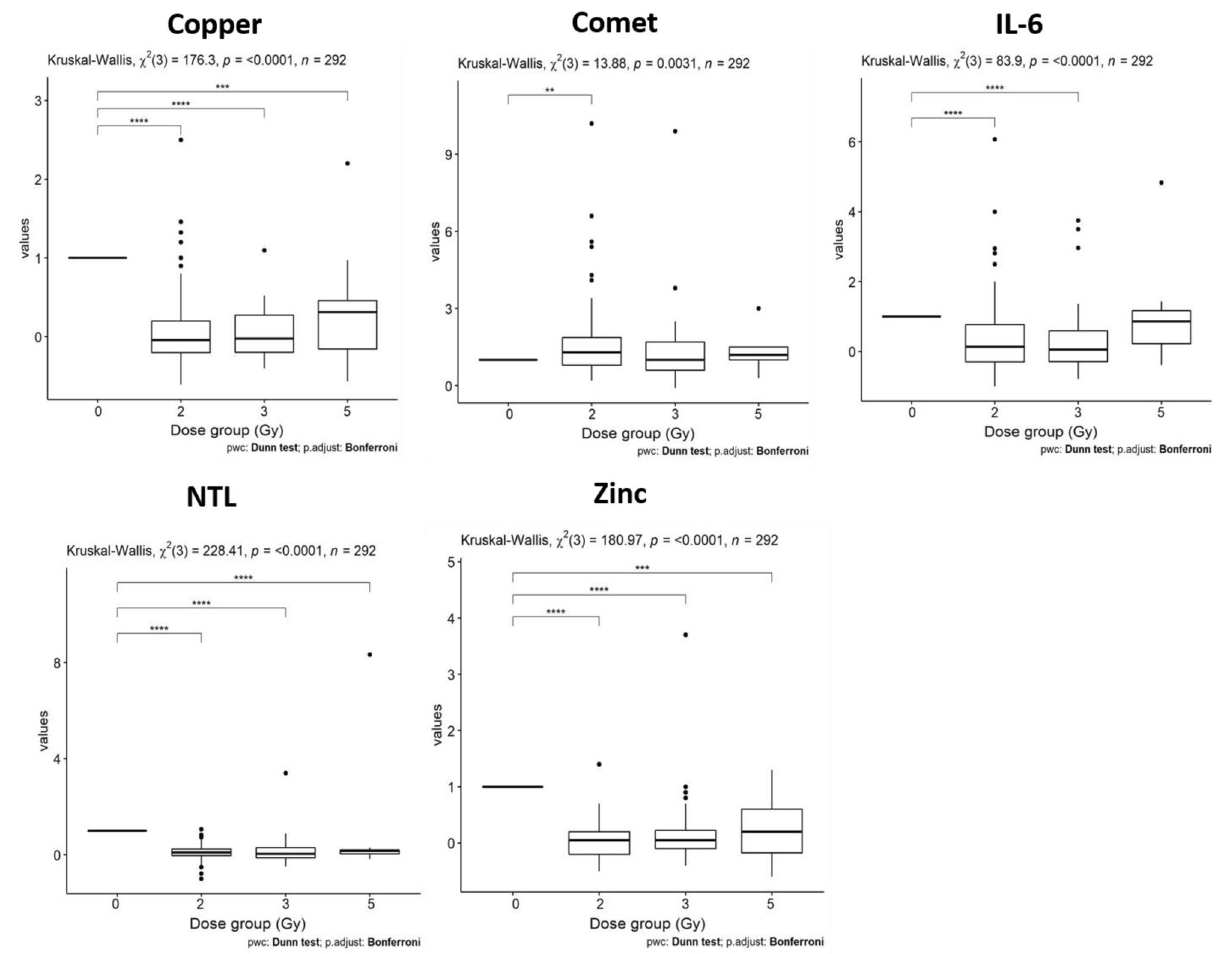
Figure 3. The boxplots of calculated relative change of values of the investigated biomarkers based on the standard test (CBC) according to the PTV dose group (in Gy) representing the dose delivered to a partial-body area. The baseline relative values are indicated as 100%. Boxplots have lines extending from the boxes (whiskers) indicating the 25th and 75th quartiles. Circle dots represent potential